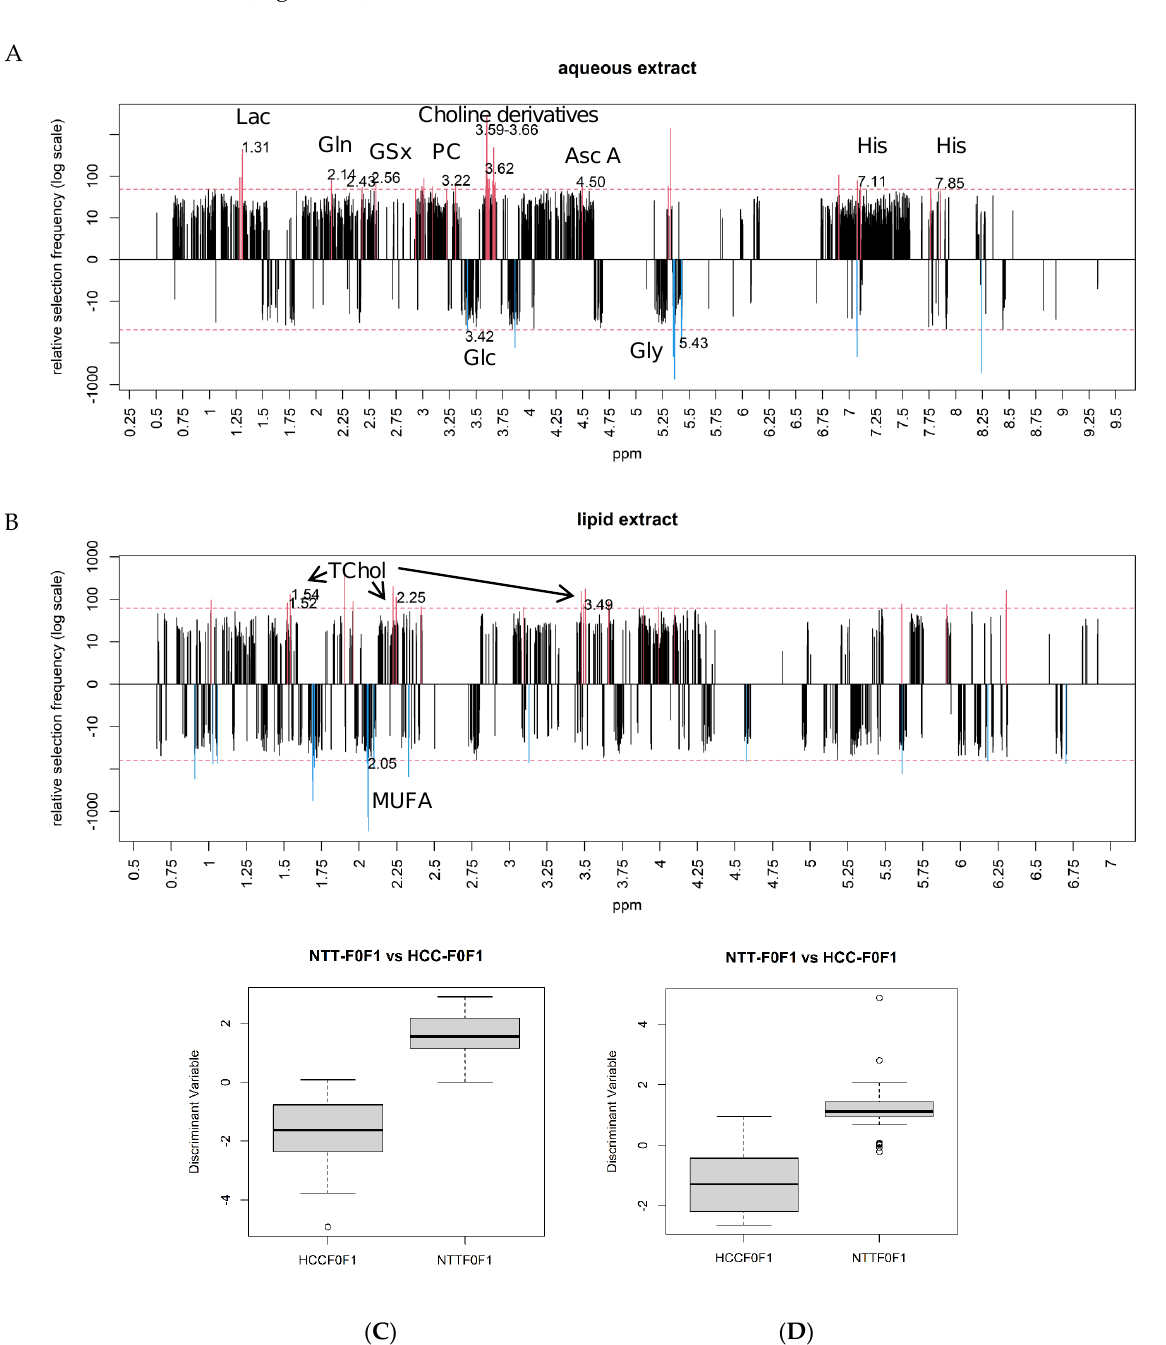
Figure 1. Frequency of selection of each ppm location in the aqueous ( A ) and lipid phases ( B ) from the comparison between hepatocellular carcinoma (HCC)-F0F1 and non-tumoral tissues (NTT)-F0F1. Discriminant metabolites (above the number of selection threshold in dotted line) are illustrated in red for upregulated and blue for downregulated metabolites in HCC. In the aqueous phase ( A ), lactate (ppm 1.31), glutamine (ppm 2.14/2.43), glutathione (ppm 2.56), phosphocholine (ppm 3.22), choline derivatives (ppm 3.59–3.66), ascorbic acid (ppm 4.50), histidine (ppms 7.11/7.85), glucose (ppm 3.42), and glycogen (ppm 5.43) were identified as discriminant metabolites. In the lipid phase ( B ), total cholesterol (ppm 1.52–1.54/2.25/3.49) and monounsaturated fatty acids (ppm 2.05) were identified as discriminant metabolites. Subsets of metabolites in the aqueous ( C ) and lipid phases ( D ) demonstrated significant accuracy to differentiate HCC from NTT in F0F1